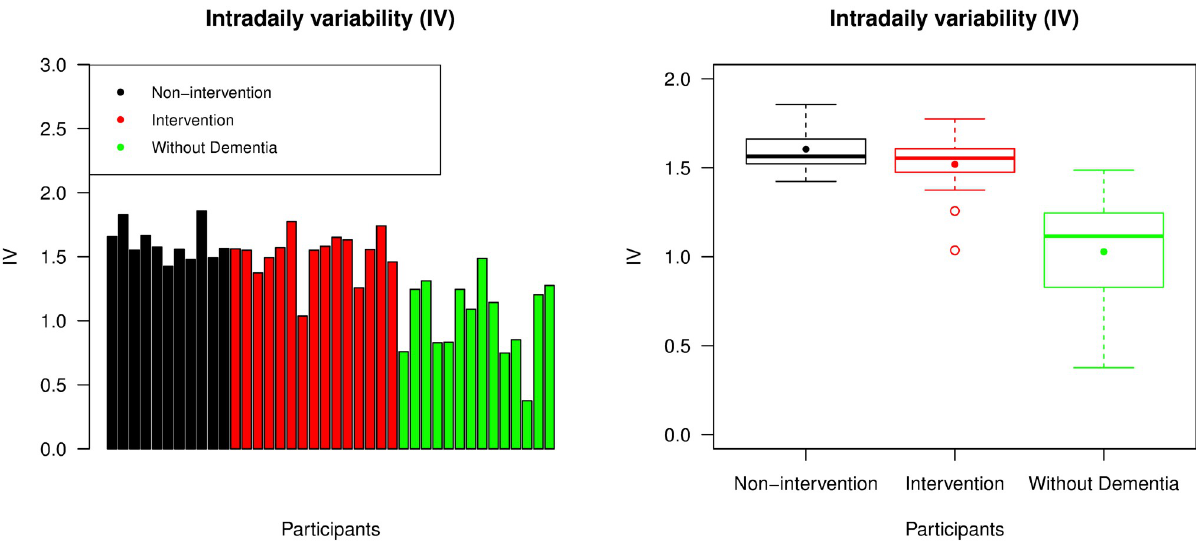
Fig 4. Intradaily variability (IV). The left panel displays IV values across all participants, with the same ordering of individuals as the bar chart representing IS values; the right panel is a box plot collating IV values across the non-intervention group, the intervention group, and the group of individuals without dementia. For each group, the median and mean of the IV values are presented by a thick line and a point in its own box, respectively.